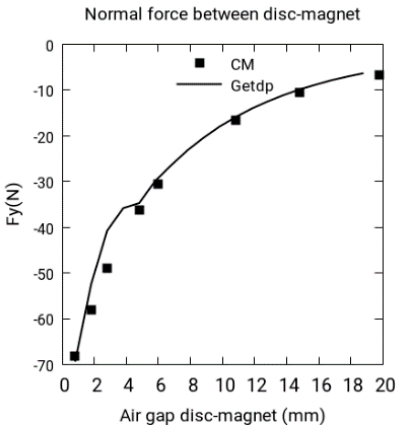
Figure 5. Normal force Fy with Wr = 34.55 rad/s, cell method (CM) vs. Getdp.